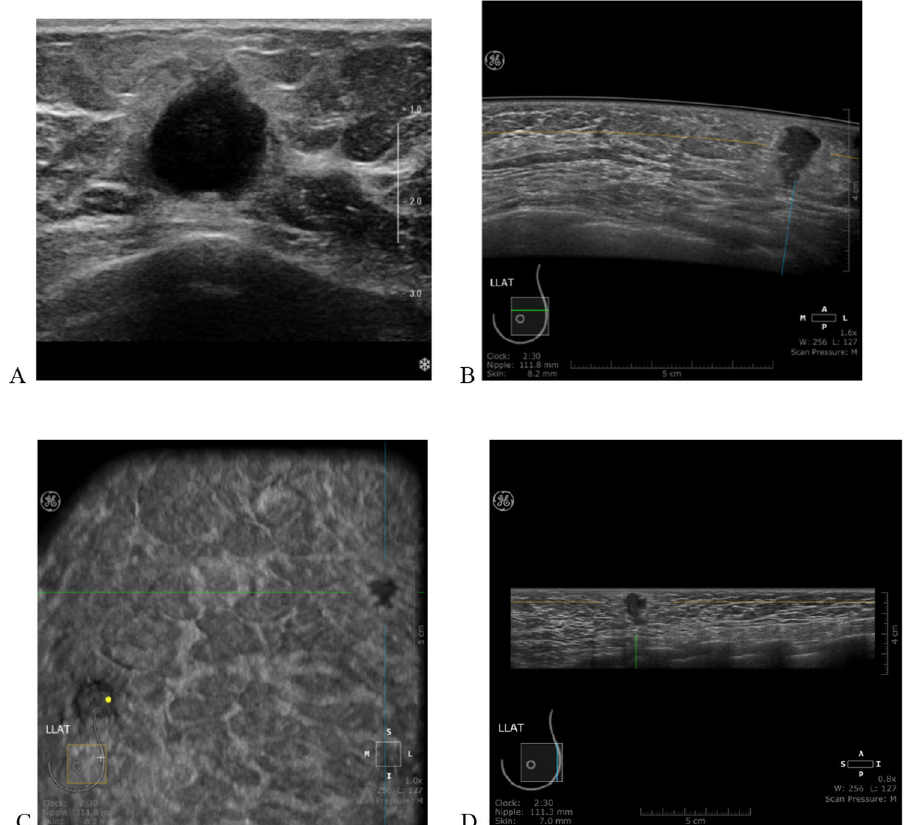
Figure 2. A 32-year-old woman with ductal carcinoma of the left breast. ( A ) shows a hypoechoic lesion with handheld ultrasound (HHUS). And ( B , C , D) show the heterogeneous hypoechoic lesions in the medial ( B ), lateral ( D ), and anterior–posterior ( C ) position of Automated Breast Ultrasound